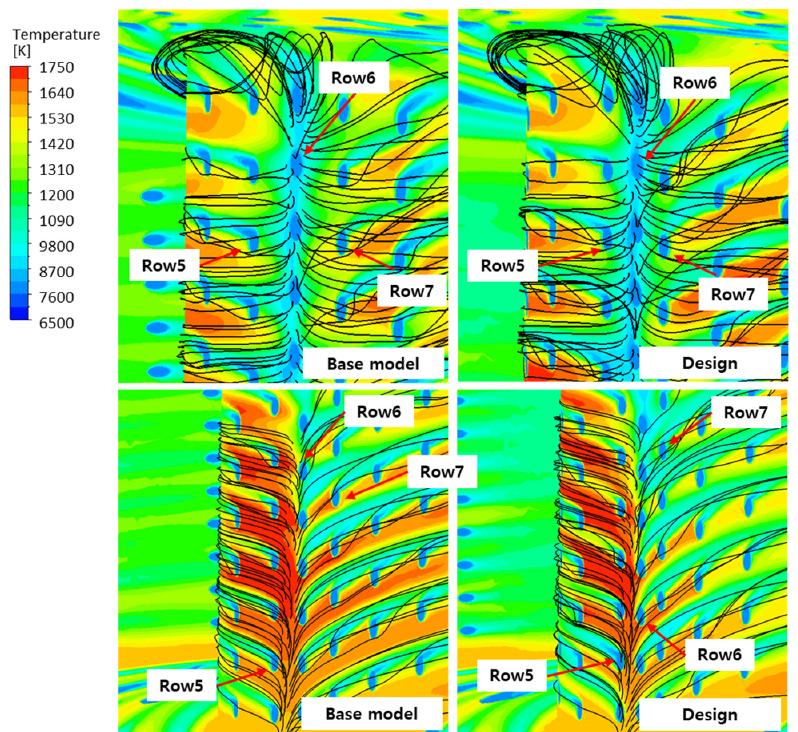
Figure 12. Temperature distribution and streamline around the leading edge (adapted with permis- sion from [16]; copyright 2021 Korean Society for Fluid Machinery).